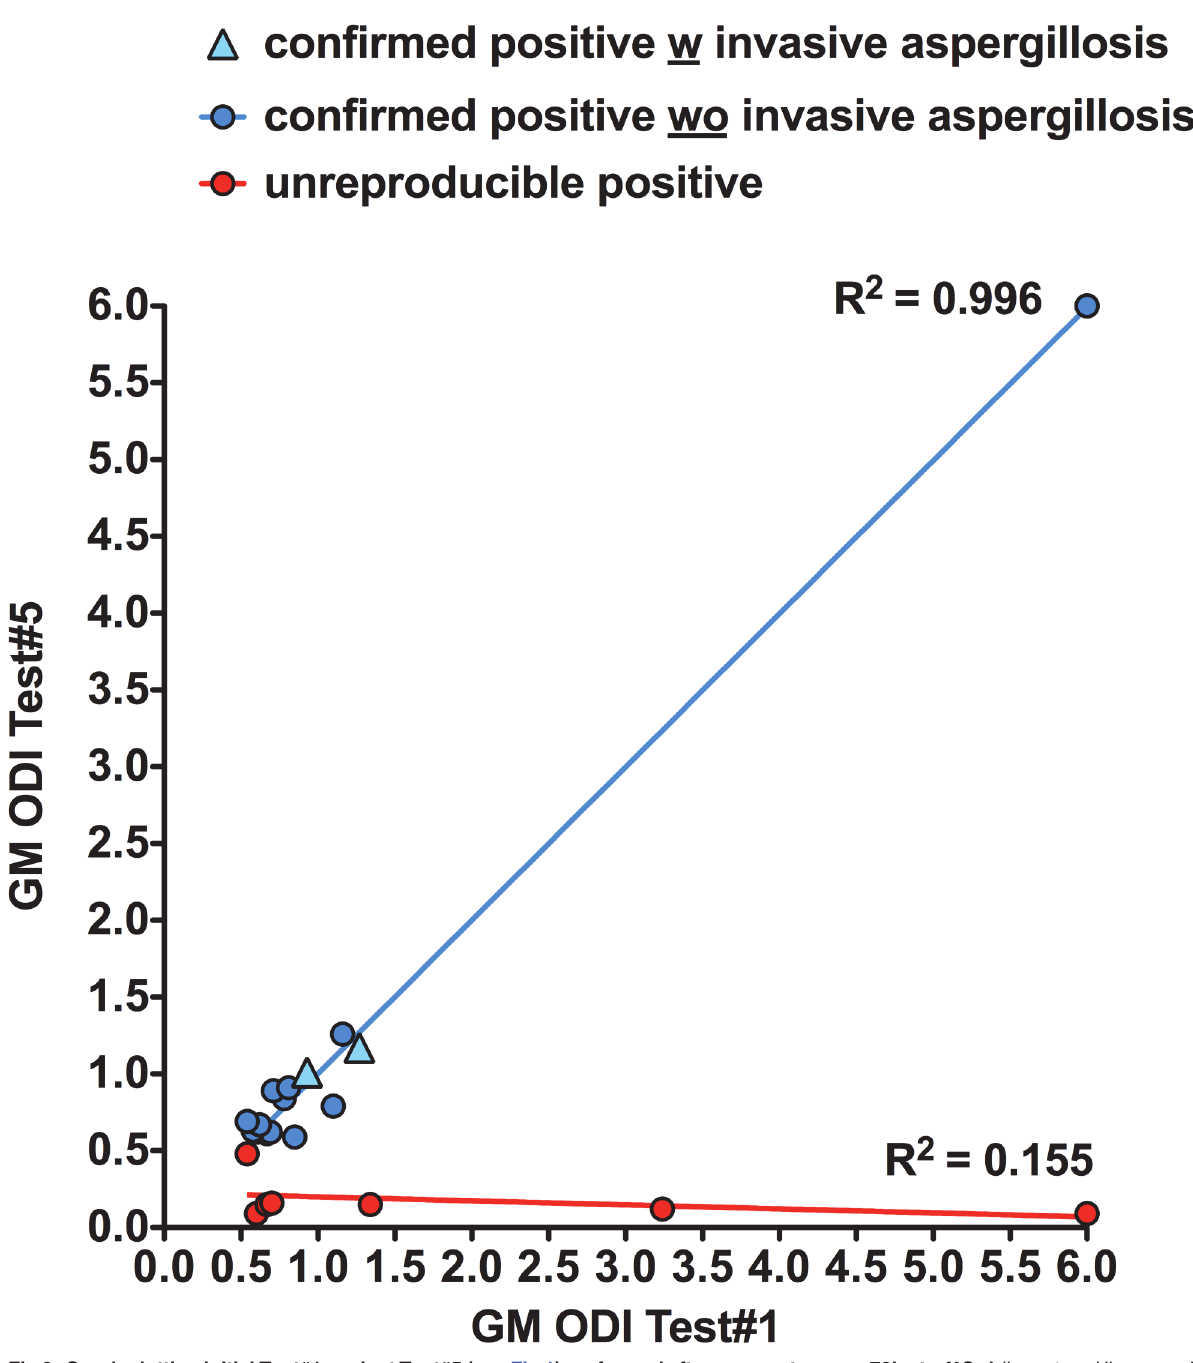
Fig 2. Graph plotting initial Test#1 against Test#5 (see Fig 1) performed after serum storage (cid:3) 72h at +4°C. A linear trend line was observed for confirmed positive and unreproducible positive results as in Fig